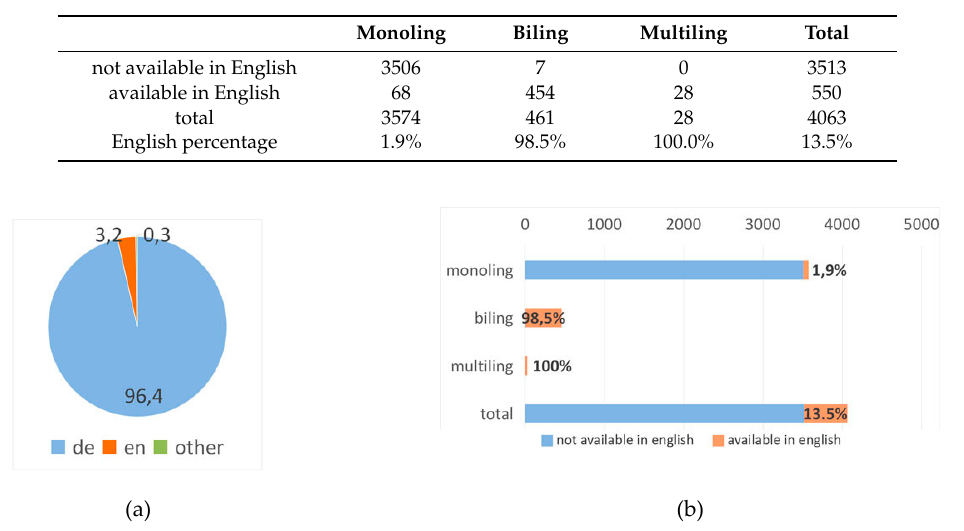
Table A2. English language availability (at).